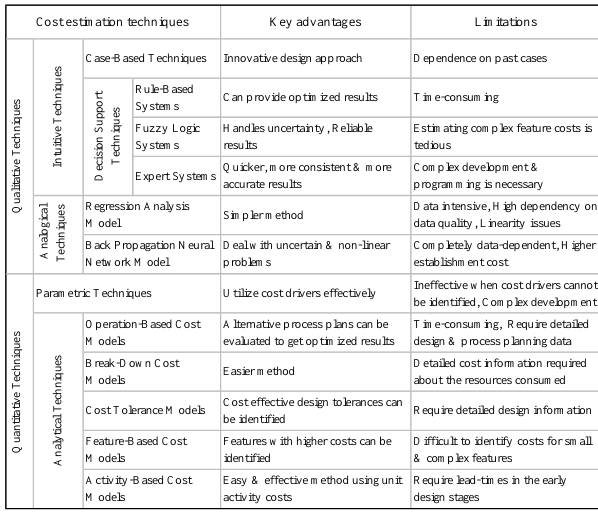
Fig. 3: Accuracy of the cost estimation techniques, adapted from [3,21]